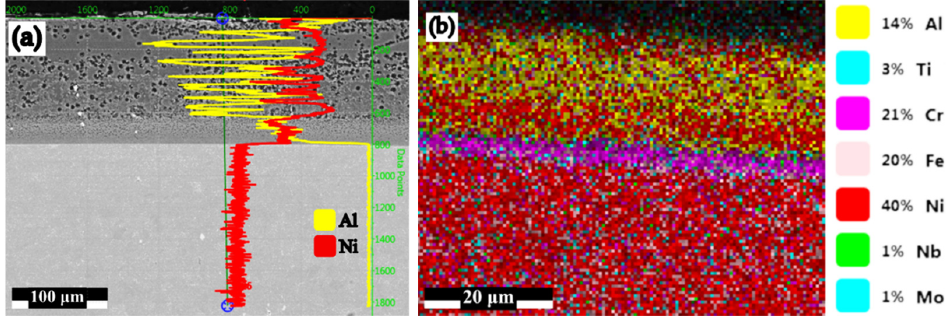
Figure 6. Al and Ni profile plot for a pack aluminized IN 718 superalloy (900 °C/5 h) in pack aluminizing mixture (50 wt.% Al + 49 wt.% Al 2 O 3 + 1 wt.% NH 4 Cl) ( a ); the main alloying elements distribution ( b ).